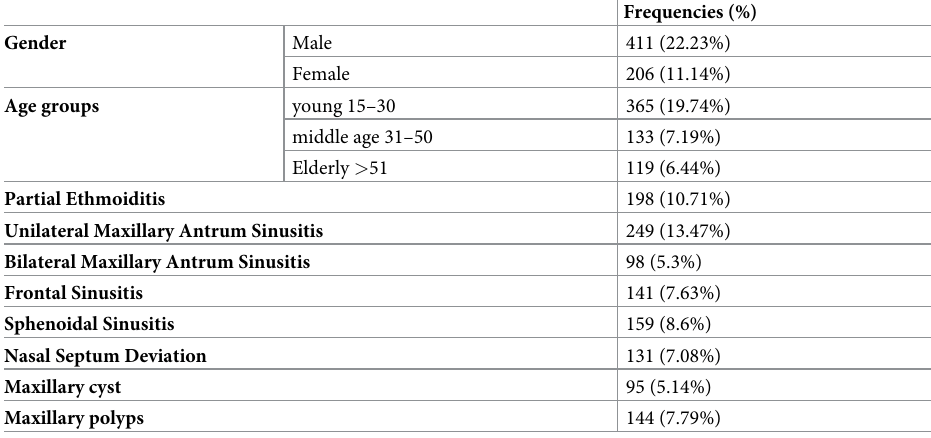
Table 1. Shows the frequencies and percentage of the sociodemographic data as well as the pathological findings of the positive